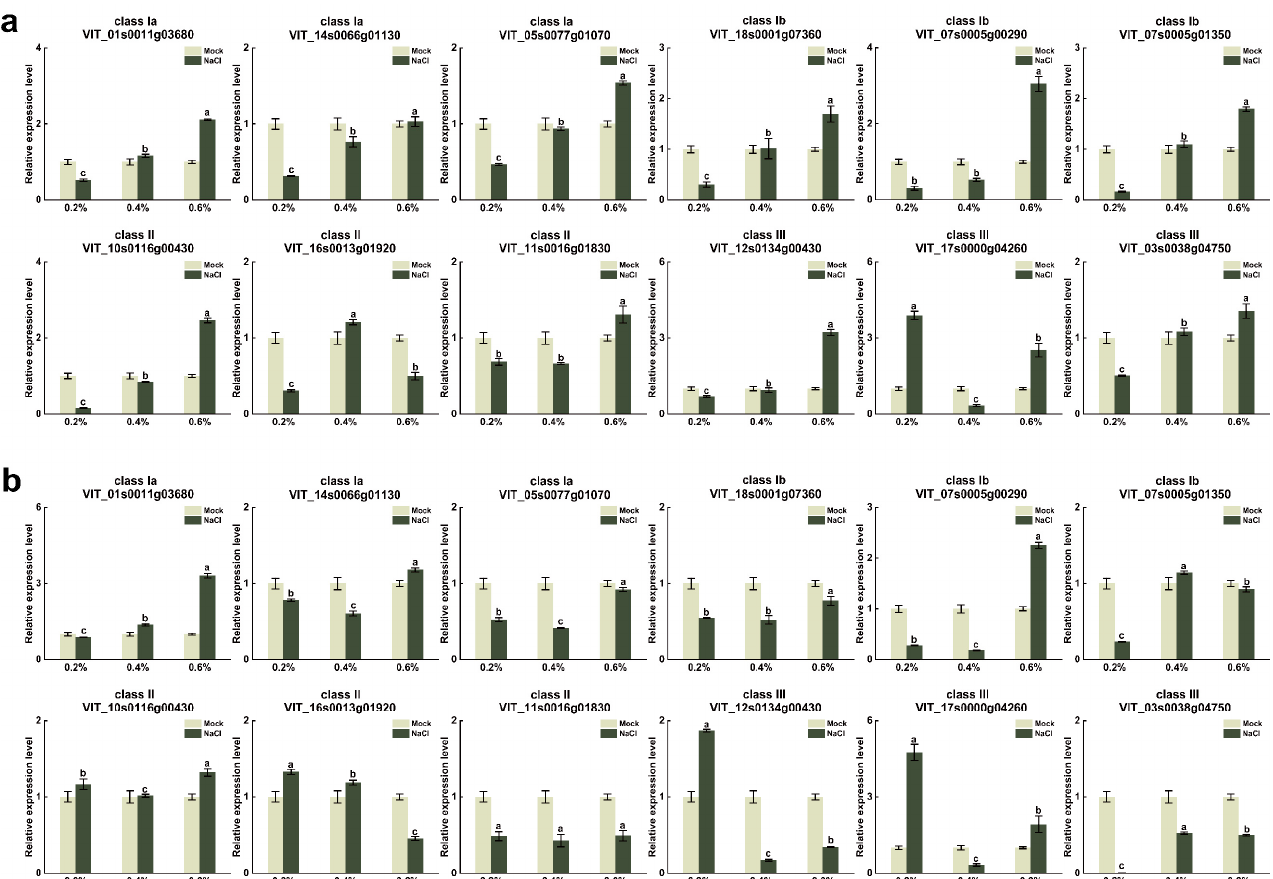
Figure 8. Expression levels of VvUSP genes at 20 days ( a ) and 40 days ( b ) of salt-stress treatments by qRT-PCR. Different letters above the bars indicate a significant difference ( p < 0.05).